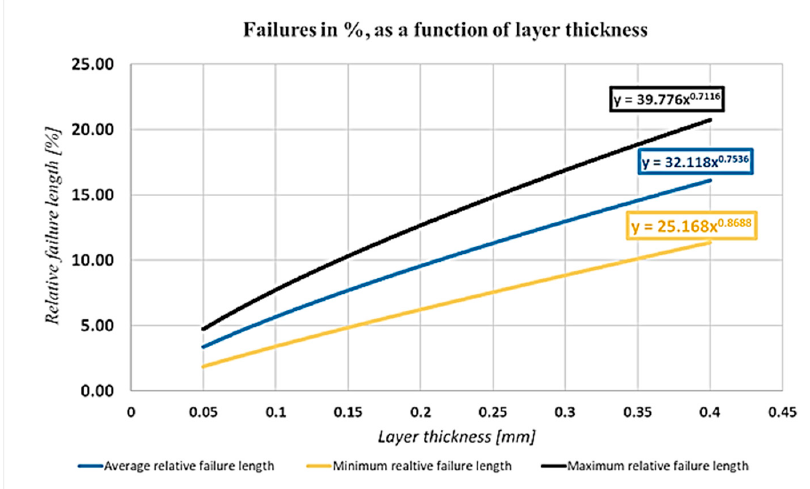
Figure 7. Effect of the failure thickness.